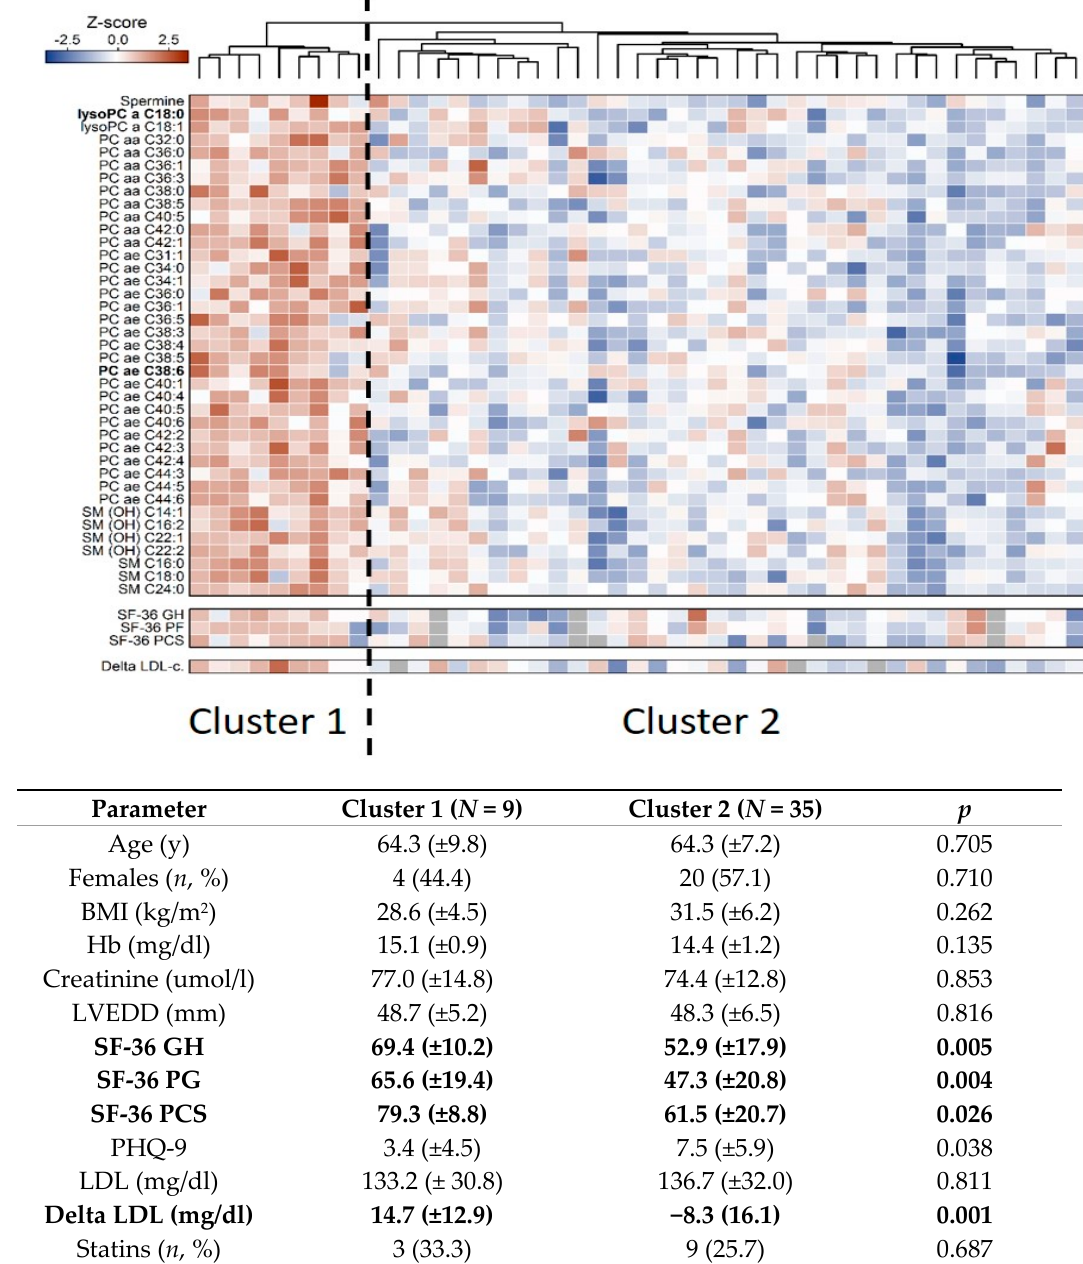
Figure 2. Metabolic response to exercise training in heart failure with preserved ejection fraction (HFpEF) patients. The top heatmap displays the results of the non-supervised clustering by similarity in metabolite concentration change from baseline to follow-up in the rows. Study participants were clustered according to similarity in response to exercise training (ET) displayed by the dendogram located on the top of the heatmap. The two smaller heatmaps on the bottom show the results of the random forest analysis, which included baseline parameters (self-perceived well-being based on the SF-36 questionnaire) and change in low-density lipoprotein (LDL) from baseline to follow-up as well as two metabolites (in bold lettering: lyso PC a C:18 and PC ae C38:6), which significantly influenced